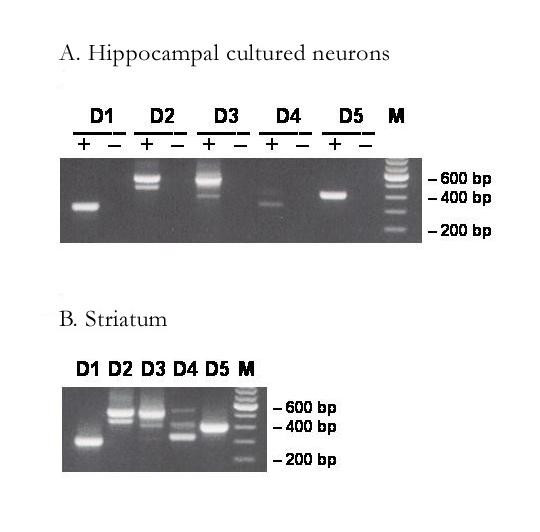
Agarose gel electrophoresis showing RT-PCR products of dopamine receptor subtypes (D1 to D5) mRNAs in rat hippocampal neurons (A) and whole striatum (B). Lanes (+) and (-) represent the PCR products amplified from hippocampal neurons cDNAs following reverse transcription in the presence or absence of reverse transcriptase, respectively. The two hippocampal cultures gave identical results. Expected size for PCR products: D1, 300 bp; D2, 538 bp and 451 bp; D3, 523 bp and 410 bp; D4, 324 bp; D5, 403 bp. Lane M, molecular size standard 100-bp ladder.